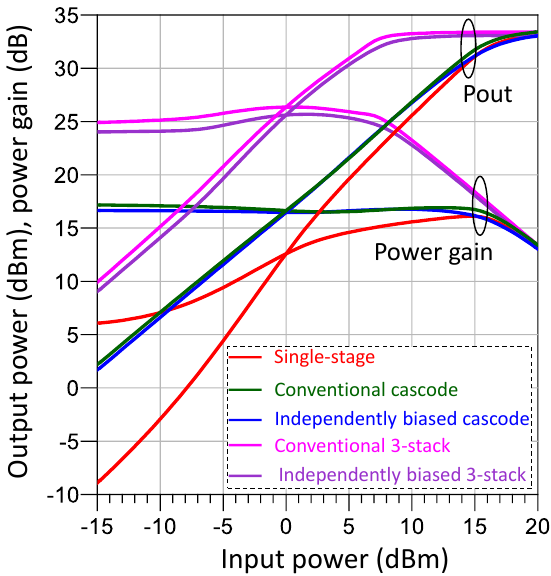
Figure 13. Output power and power gain characteristic.